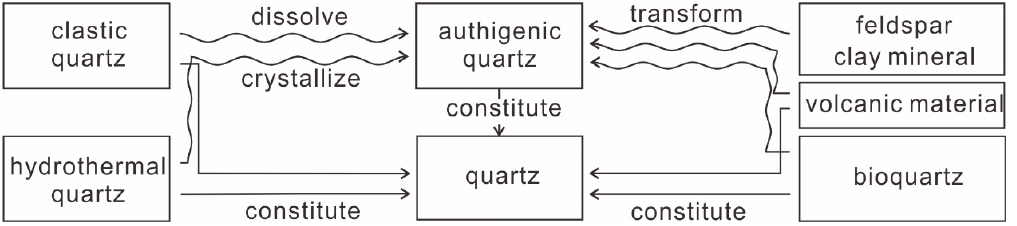
Figure 3. Quartz main composition and transformation relationships in shale.